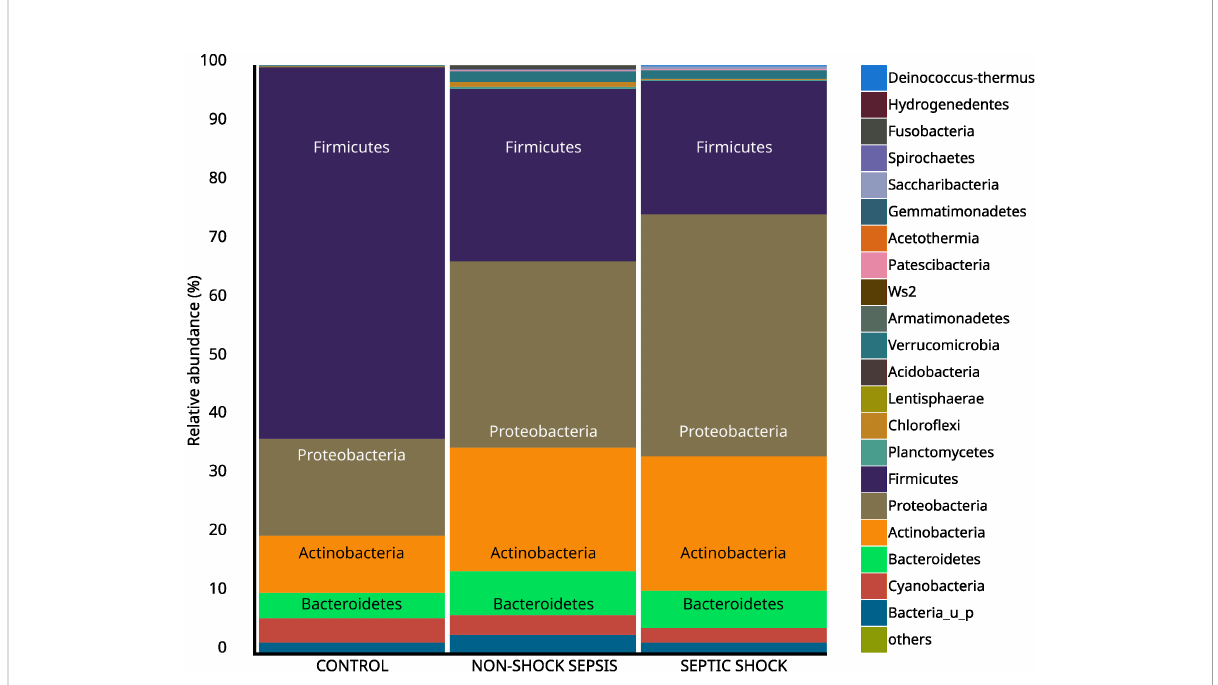
FIGURE 3 Abundance of taxa at the phylum level among non-septic control, non-shock sepsis and septic shock